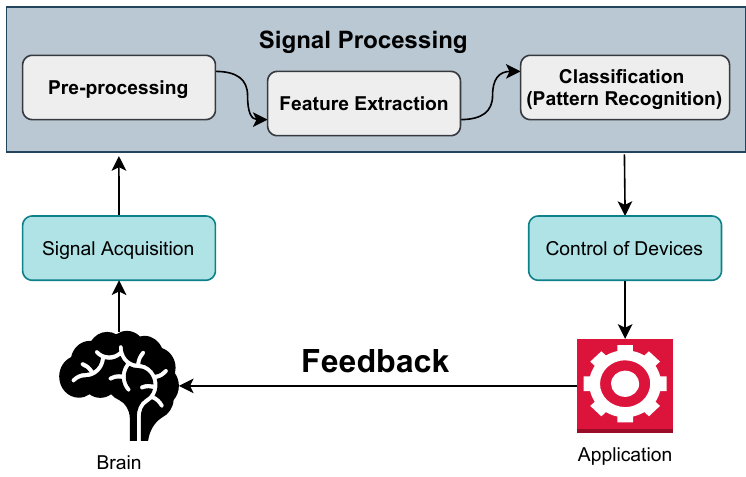
Figure 2. Basic architecture of a BCI